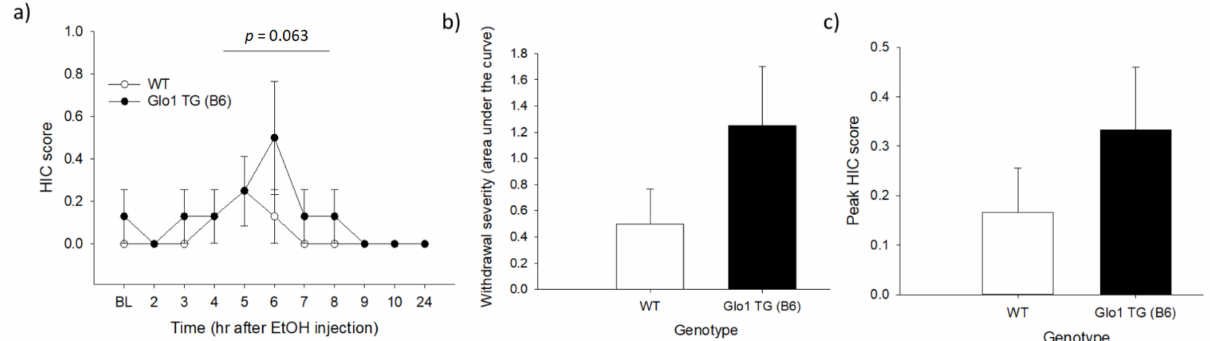
Figure 1. Acute ethanol withdrawal as assessed using handling-induced convulsions (HICs) in wild-type (WT) and Glo1 - overexpressing (TG) mice on a C57BL/6J (B6) genetic background. Panel ( a ) shows the time course of the withdrawal, with baseline HIC measurements made immediately before the ethanol injection. There was a statistical trend of overexpressing mice trending toward higher HIC scores across the time course. Panel ( b ) shows the cumulative HIC scores (area under the curve (AUC)) for each genotype. Panel ( c ) shows the peak HIC score for each genotype. Genotype differences for both the AUC and peak HIC scores were not statistically significant. n = 8/genotype.